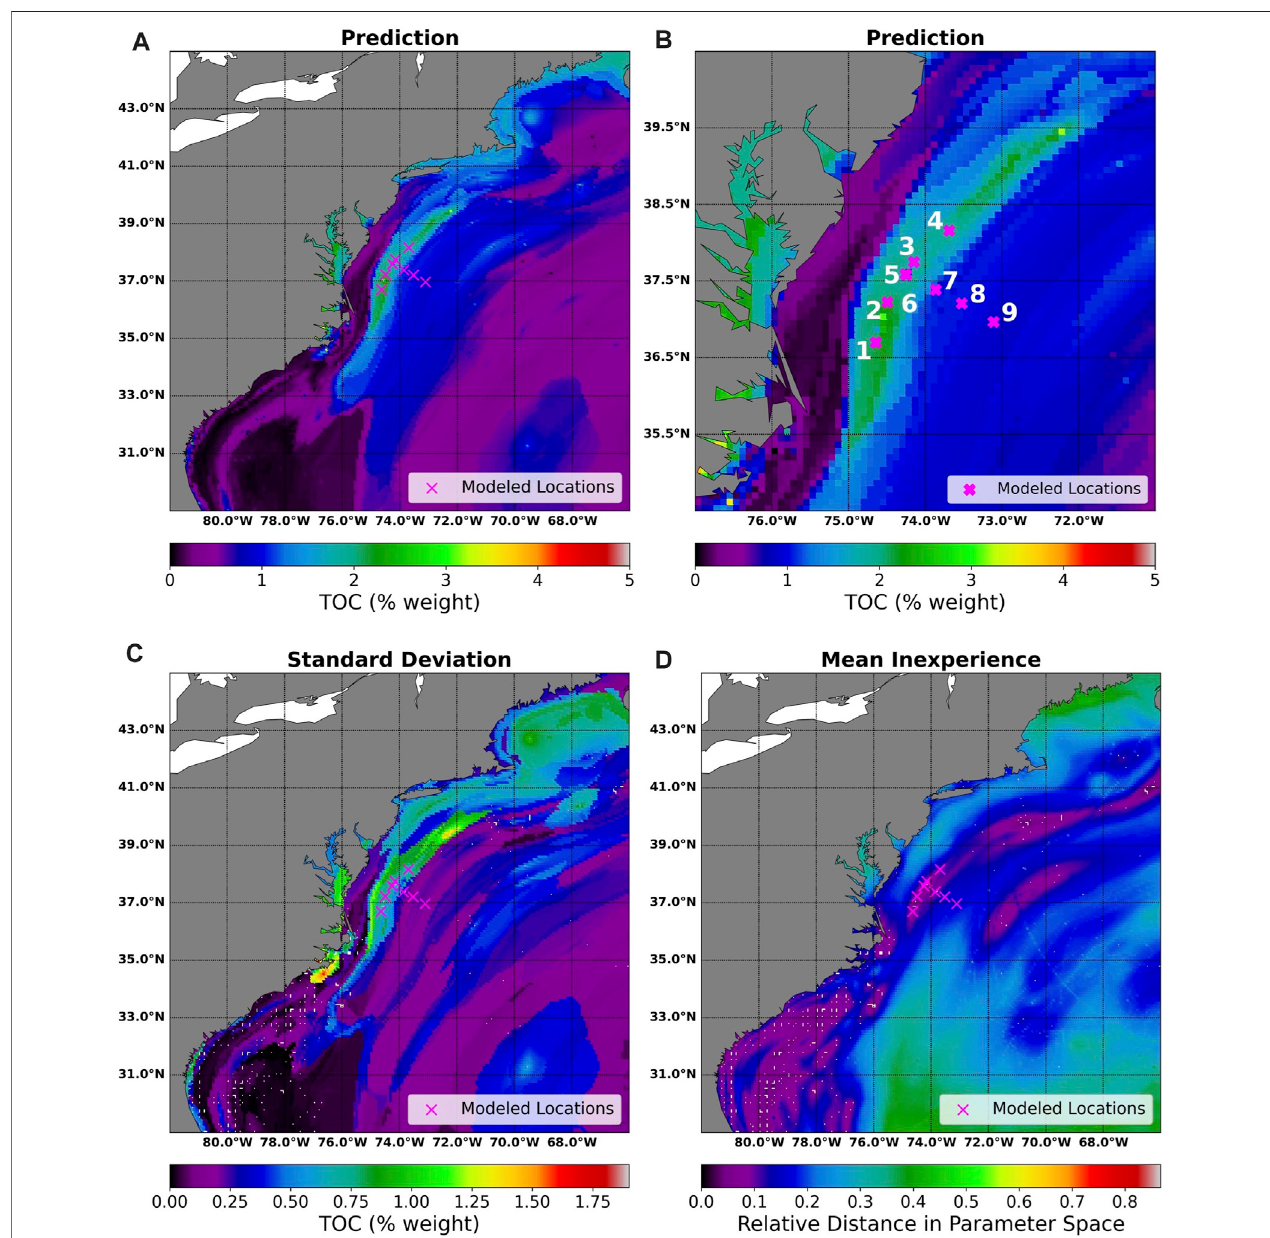
FIGURE5| OutputmapsfromGPSMoverthearea29 ° N – 45 ° Nand82 ° W – 66 ° W.Plot (A) depictsthepredictedweightpercentoftotalorganiccarbon(TOC)onthe sea fl oor. Plot (B) is the same mapped zoomed in around the area of interest with the locations modeled with PFLOTRAN/Dakota numbered. Between (35.4 ° N, 75.0 ° W) and (39.0 ° N, 72.0 ° W) an area of increased sea fl oor TOC was predicted. The locations along the shelf strike can be found in this area. Plots (C,D) show the standard deviation and mean inexperience of predictions over the region. Locations with known TOC values are marked by white dots on the standard deviation and mean inexperience maps. The nine locations where gas and hydrate formation was modeled are marked with a magenta ×.